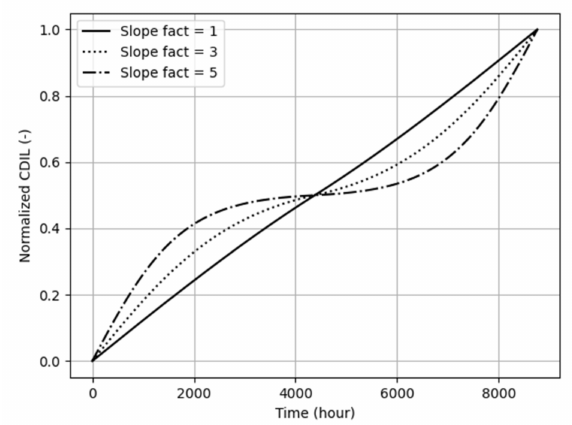
Figure 7. Internal appliance